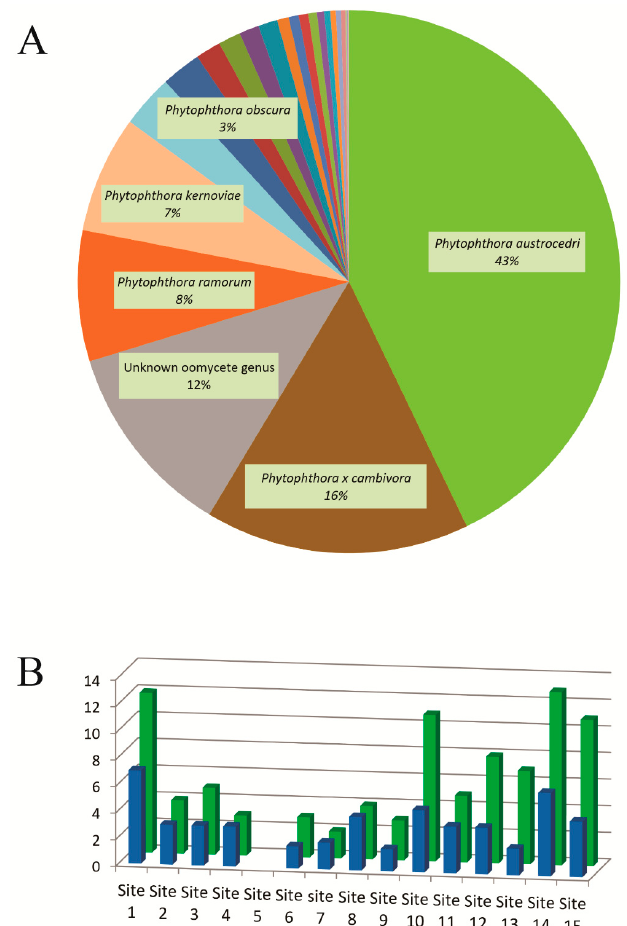
Figure 2. ( A ) Percentage of Illumina reads corresponding to each assigned species in soil samples from Patagonia. Only species with ≥ 3% of readings are labeled. ( B ) Mean richness per sample (blue bars) and total richness (green bars) of each site. No Phytophthora DNA was detected in site 5. Phytophthora species were detected in seven out of ten clades recognized by Yang et al. [22]. Fifty- seven percent of reads corresponded to species in clade 8; 16% to species in clade 7; 7% to species in clade 10; and 4% to species in clade 3. Clades 1, 2, and 6 were represented in 2% or less of the reads, and species in clades 4, 5, and 9 were not detected (Figure 2a).